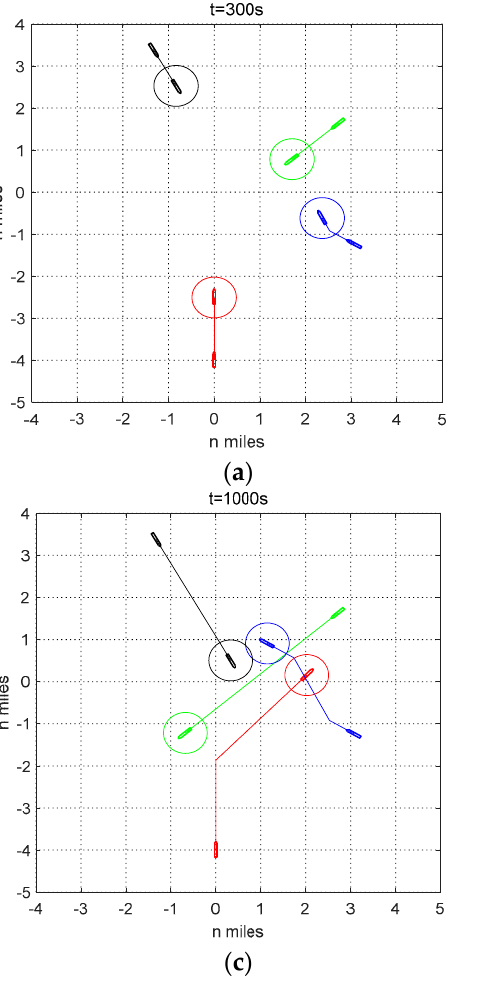
Figure 7. Ships’ trajectories under scenario 2: ( a ) the positions and paths of ships at 300 s, ( b ) the positions and paths of ships at 700 s, ( c ) the positions and paths of ships at 1000 s and ( d ) the positions and paths of ships at 1500 s.